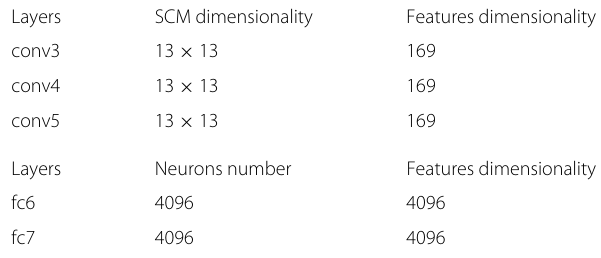
Table 4 Classification accuracy (%) with multimodal information Method